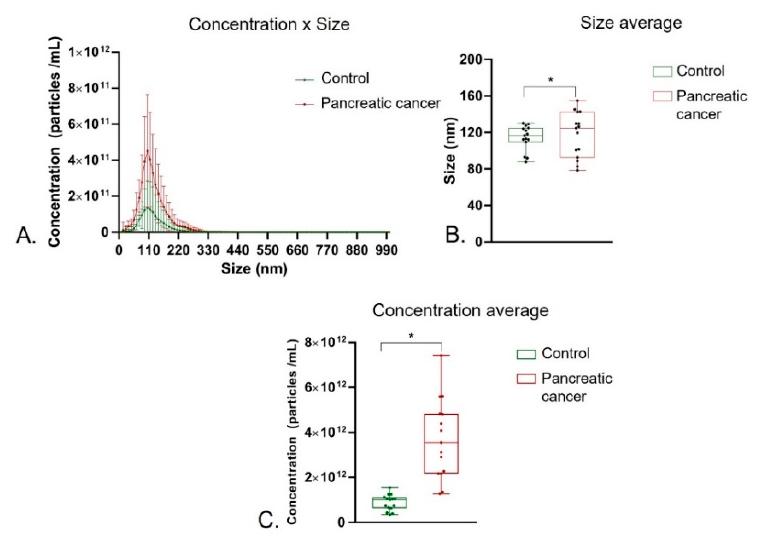
Figure 1. Nano tracking analysis of plasma exosomes isolated from healthy individuals and pancreatic cancer patients. ( A ) Concentration average of exosome population observed between control group and pancreatic cancer patients. ( B ) Average size of exosome population observed between control group and pancreatic cancer patients. ( C ) Comparation of population concentration profile exosome plasma, from control group and pancreatic cancer patients ( A , B ). The results were analyzed by t -test, comparing the plasmas of patients with the control. (* p ≤ 0.05). EV: extracellular vesicle .